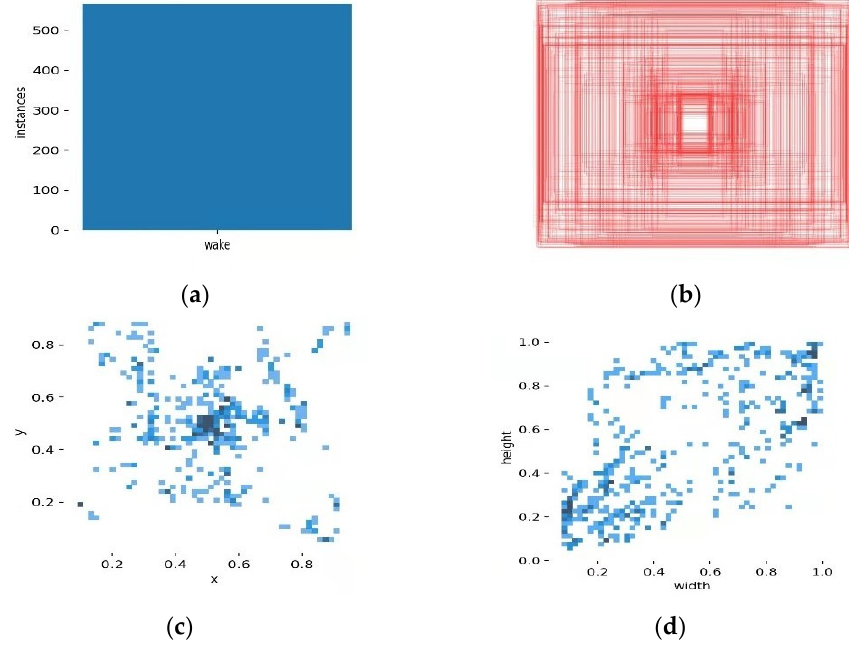
Figure 13. Statistical diagram of the ship wake training model. ( a ) sample number of the data sets; ( b ) annotation boxes; ( c ) locations of the targets; ( d ) spatial size of the targets.